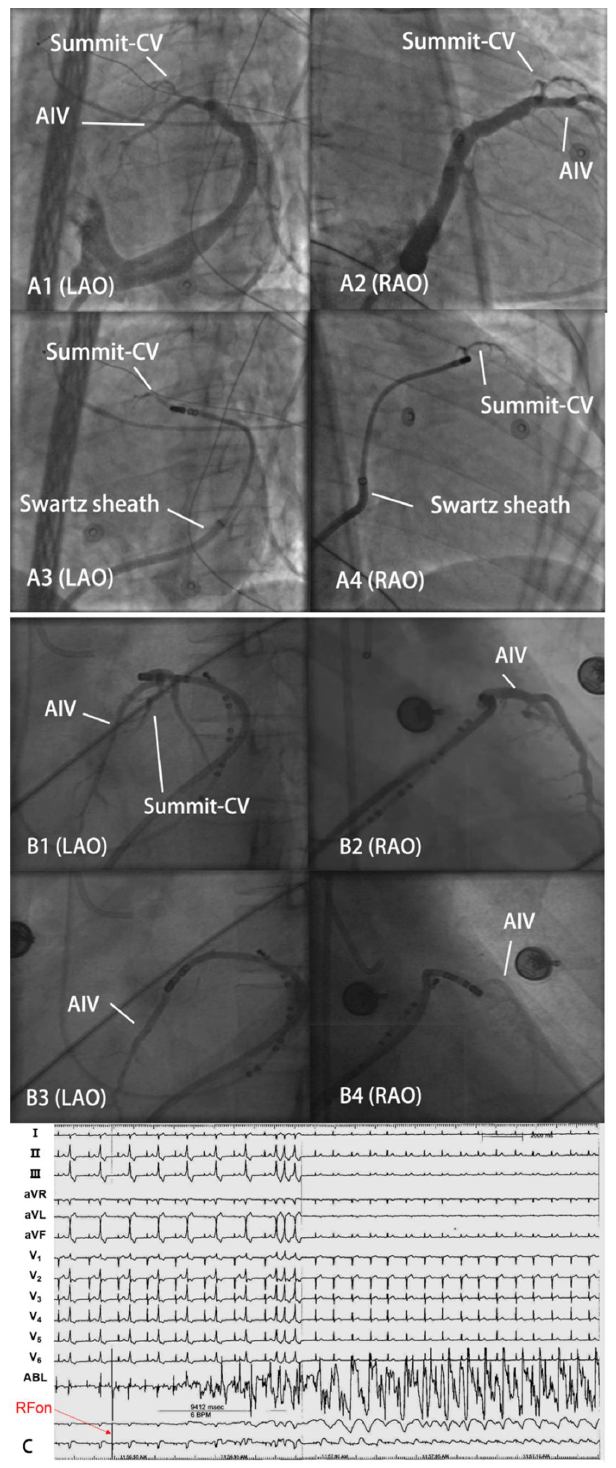
Figure 1. The CVG and electrocardiogram of typical cases. ( A1 – A4 ) shows that the catheter tip reached Summit-CV via the Swartz sheath support approach. ( B1 – B4 ) shows the catheter tip inserted to AIV directly. ( C ) Sample electrocardiogram of a successful ablation of PVC originating from DGCV2. RFon indicates the beginning of radiofrequency energy delivery. The RF energy was delivered at the limit temperature of 43 ◦ C, power of 30 W with a 60 mL/min saline flow